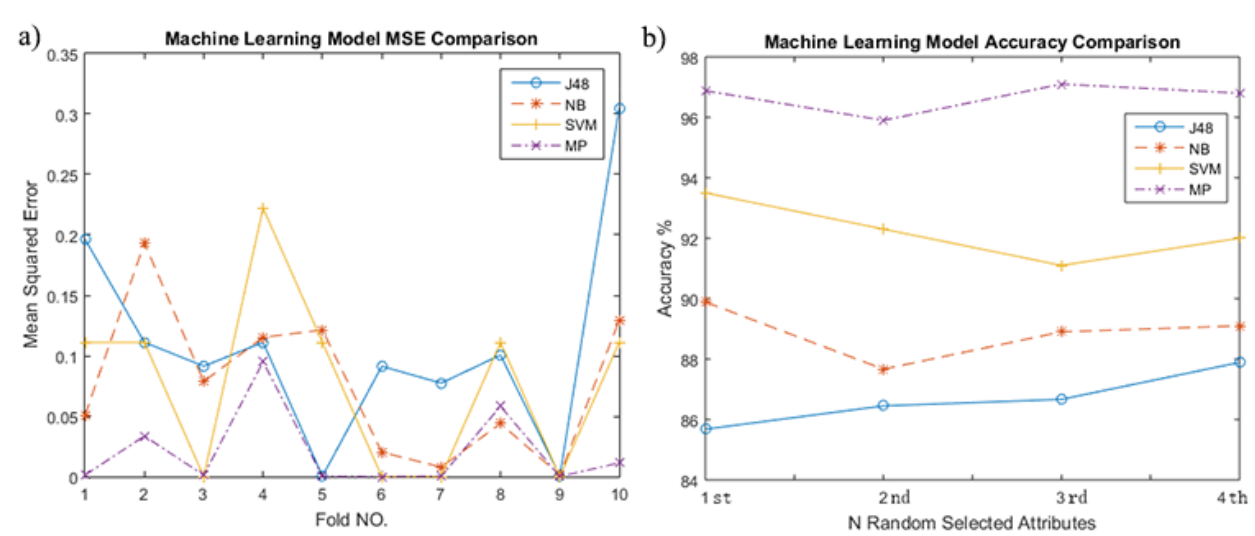
Figure 7. (a) Evaluation of 10-fold cross-validation Mean Squared Error (MSE) of each fold for different machine learning models. (b) Accuracy of N random selected attributes.